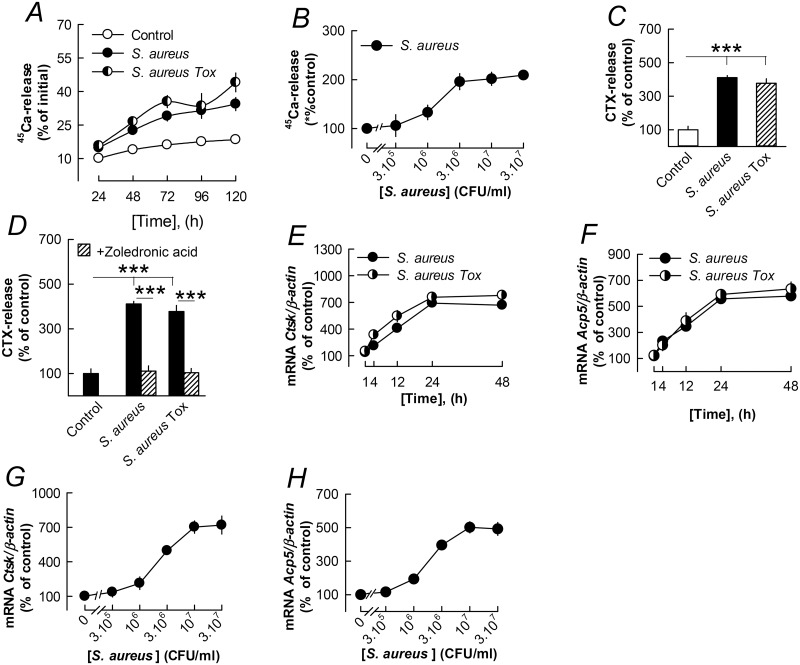
S. aureus stimulates bone resorption and expression of osteoclastic and osteoclastogenic genes in organ cultures of neonatal mouse parietal bones.(A-C) S. aureus time- and concentration-dependently increased 45Ca and CTX release from the parietal bones. (D) The stimulatory effect by S. aureus (3x106 CFU/ml) on CTX release was inhibited by zoledronic acid (0.2 μmol/l). (E, F) S. aureus (3x106 CFU/ml) time-dependently upregulated the mRNA expression of Ctsk and Acp5 in the parietal bones. (G, H) Concentration-dependent effects by S. aureus on Ctsk and Acp mRNA expression in the parietal bones. Data are means of 6 (A-D) or 5 (E-H) observations and SEM is given as vertical bars when larger than the radius of the symbol. In Fig 1A, all effects at 48 h and later were statistically significant (P<0.001) with the exception of S. aureus Tox at 96 h (P<0.01); at 24 h effects were also significant (P<0.05). In Fig 1B, effects by 3x106–3x107 CFU/ml were statistically significant (P>0.01). In Fig 1G, effects were statistically significant at 106 (P<0.01) and 3x106–3x107 (P<0.001) CFU/ml. In Fig 1H, effects by 106–3x107 CFU/ml were statistically significant (P<0.001). ***P<0.001 compared to unstimulated control (C, D) or to S. aureus stimulated bones (D).